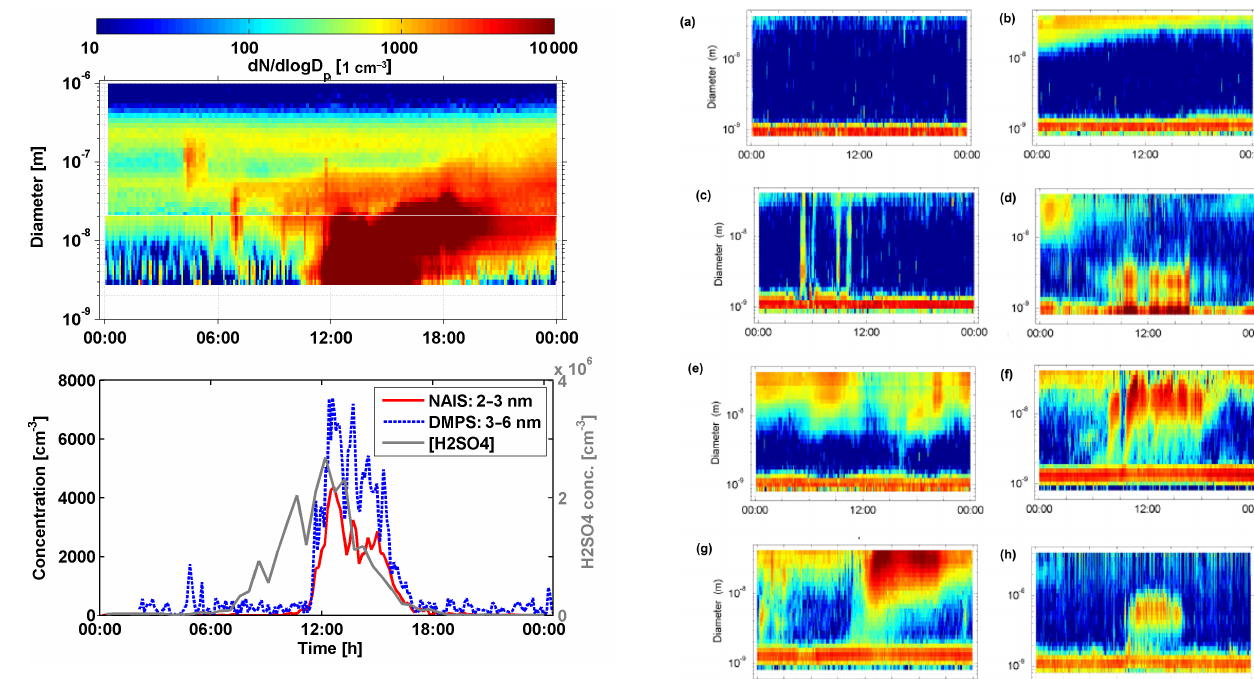
Figure 18. Example of a particle size distribution measured with the NAIS in the size range 2.5–20nm and with the DMPS in the size range 20–1000nm on 5 May 2007 in Hyytiälä (upper panel), and concentrations of 2–3nm particles measured with the NAIS, 3–6nm particles with the DMPS, and sulphuric acid (lower panel).